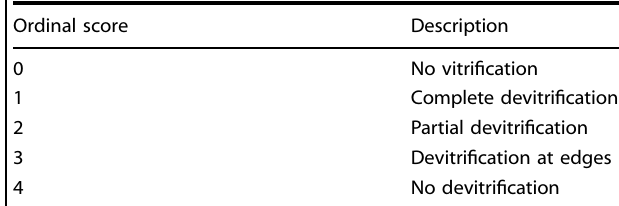
Table 4. Ordinal scores for the ordinal model of vitri fi ability 25